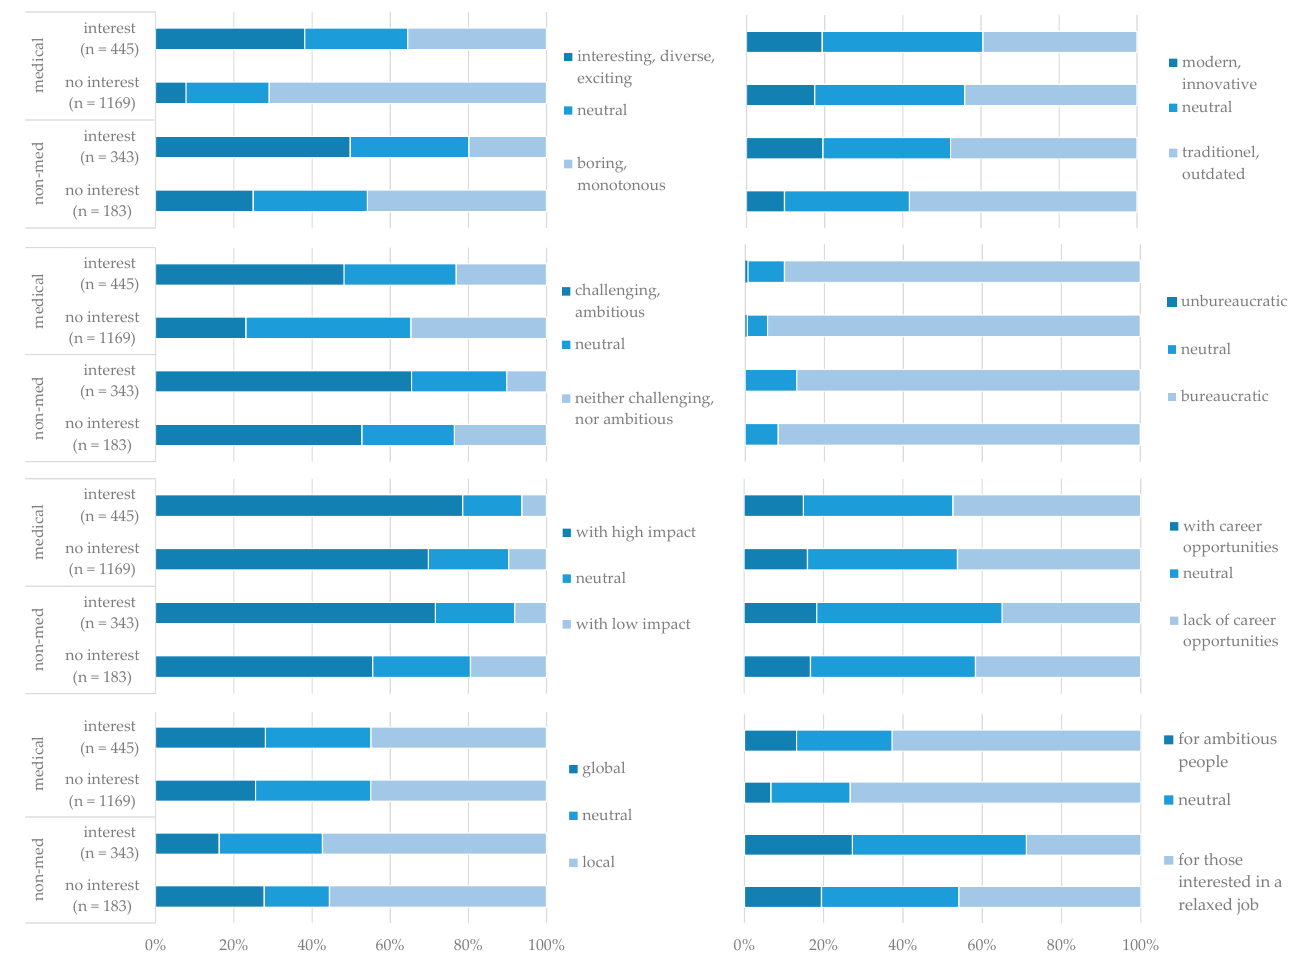
Figure A1. Relative proportion of attributes and characteristics associated with PHS. Shown are the results of a polarity profile based on eight contrasting comparisons differentiated by field of study and general PHS interest wave 1 and wave 2, OeGD-Studisurvey.